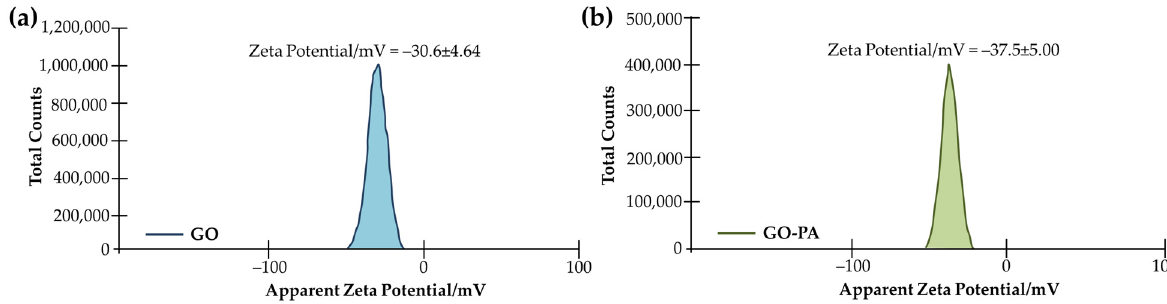
Figure 4. Average zeta potentials of GO ( a ) and GO-PA ( b ) in water dispersion.